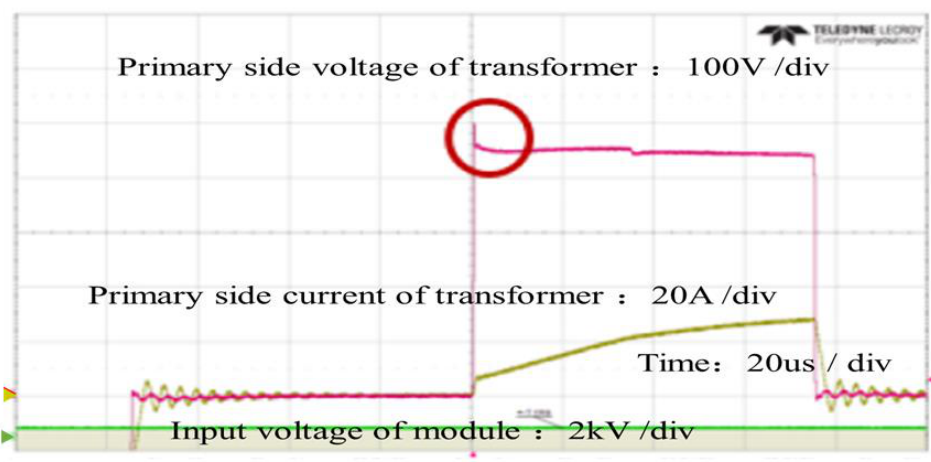
Figure 13. Voltage spike suppression with active clamping circuit.